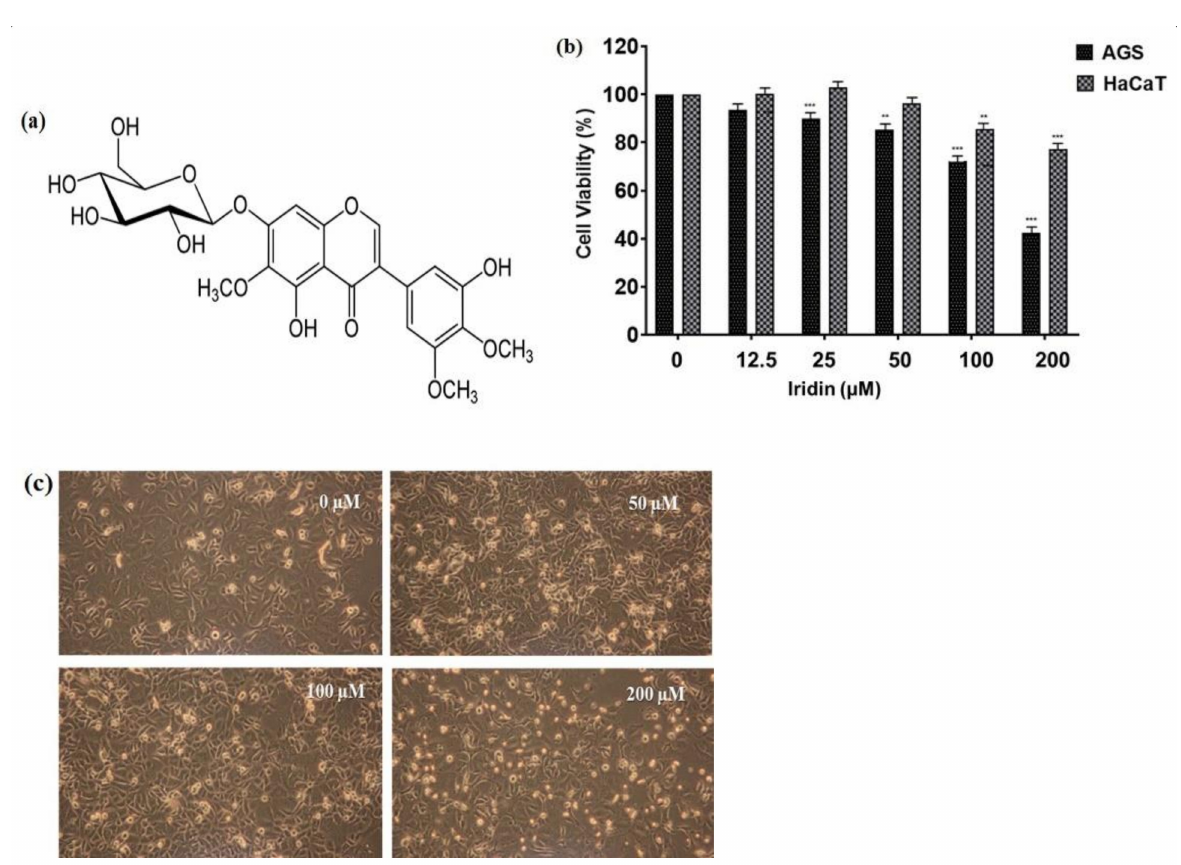
Figure 1. Effect of iridin on the viability of AGS cells. ( a ) Structure of iridin. ( b ) Determination of cytotoxicity of AGS and human keratinocyte HaCaT cells after treatment with iridin for 48 h at various concentrations (0, 12.5, 25, 50, 100, and 200 µ M) was measured by 3-(4,5-dimethylthiazol-2-yl)-2,5-diphenyltetrazolium bromide (MTT) assay. ( c ) Morphological changes of AGS cells were visualized under light microscopy ( × 400) after treatment with iridin. Bar values represent the mean, and the error bar represents the standard error of the mean (SEM) of three separate experiments. ** p < 0.01 vs. control, *** p < 0.001 vs.